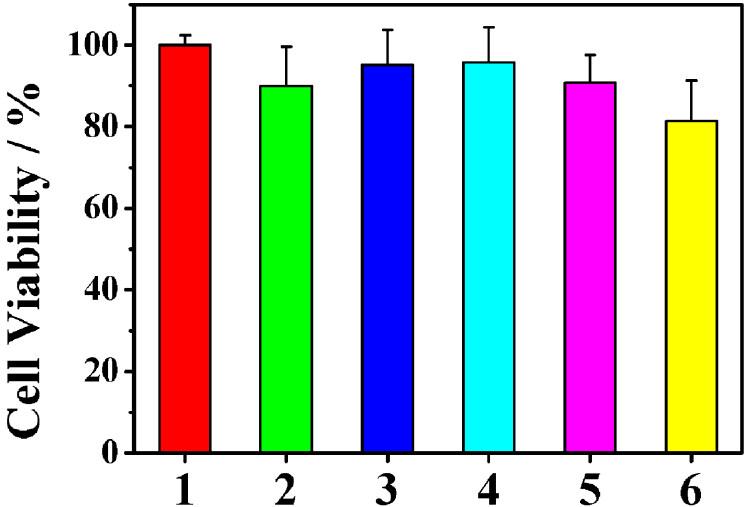
Figure 2. The cell toxicity of ICG, TpPa-1@ICG and different concentrations of TpPa-1@ICG-HG co-incubated with RAW cells for 24 h. Each experiment had been repeated three times. Error bars indicate ± s.d. 1: control (RAW cells only); 2: add 0.1 mg/mL ICG; 3: add 0.1 mg/mL TpPa-1@ICG; 4: add 0.1 mg/mL TpPa-1@ICG-HG; 5: add 1.0 mg/mL TpPa-1@ICG-HG; 6: add 2.0 mg/mL